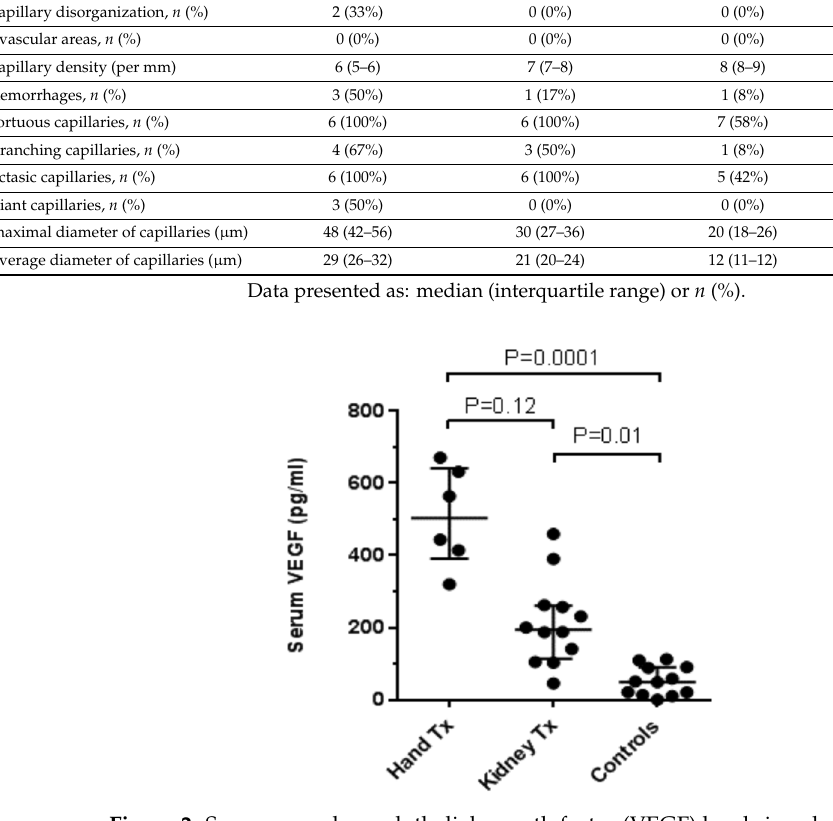
Figure 3. Correlation between serum VEGF levels and average capillary diameter.